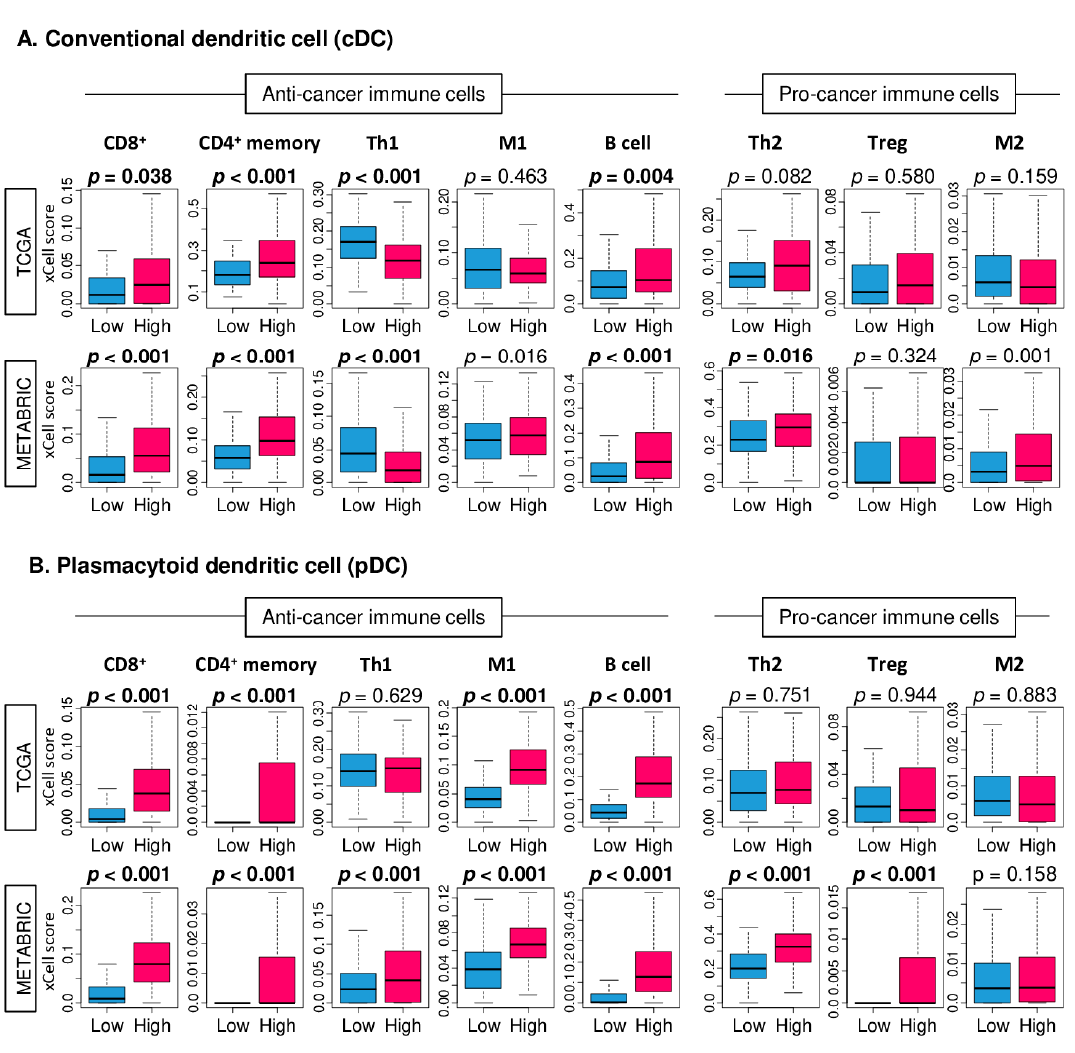
(Figure 6A; p = 0.029, < 0.001, 0.002, and < 0.001 for the TCGA, and p = 0.031, < 0.001, < 0.001, and < 0.001 for the METABRIC, respectively). On the other hand, the high pDC TNBC group was significantly associated with the high expression of all nine immune checkpoint molecules examined: PD-1, PD-L1, PD-L2, CTLA-4, IDO1, IDO2, LAG3, HLA-A , and TIGIT in both cohorts (Figure 6B). These results suggest that the high pDC fraction TNBC may possibly respond to immune checkpoint inhibitors. Cancers 2020 , 12 , x